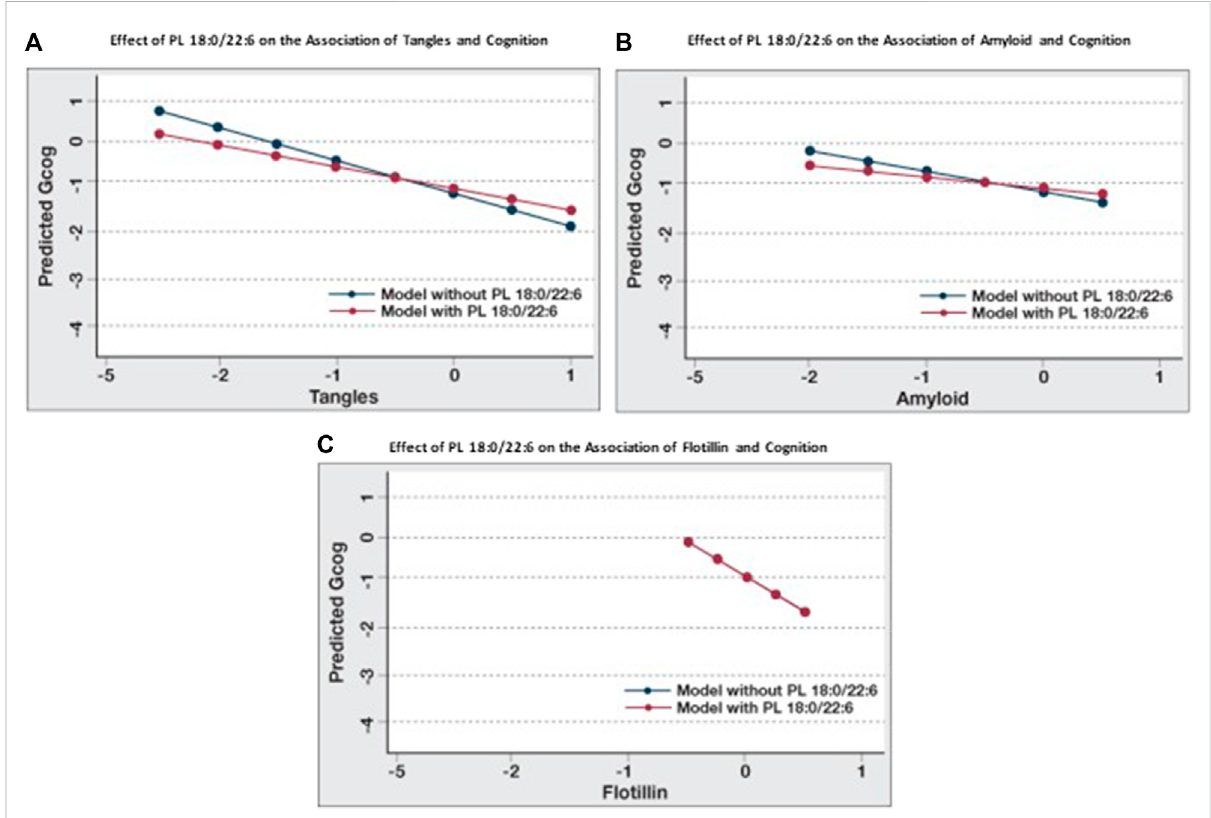
FIGURE 3 Modulation of the effects of pathological parameters on cognition by PL 18:0/22:6. Regression analyses were conducted with Gcog as the outcome variable and tangles, amyloid or fl otillin respectively as the independent variable. Two separate models for each pathological parameter, withorwithoutPL18:0/22:6inthemodel,wereconstructed.Allmodelswereadjustedforage,sexandeducation. Postestimationpredictedvalueof theoutcomevariablebybrainlevelsoftherespectivepathologicalparameterwereplottedinasinglegraphforcomparison. (A) Effectoftangles on cognition with or without PL 18:0/22:6 in the model; (B) Effect of amyloid on cognition with or without PL 18:0/22:6 in the model; (C) Effect of fl otillin on cognition with or without PL 18:0/22:6 in the model (blue and red lines are